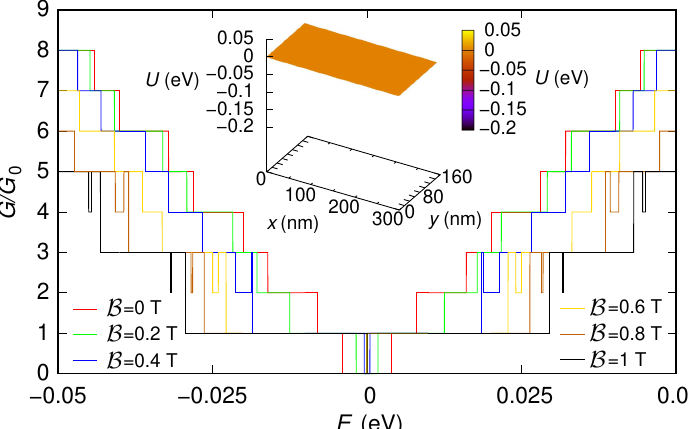
Figure 5. Conductance G , normalized with respect to the conductance quantum G 0 , which was obtained as a function of the Fermi energy E for six values of the orthogonal magnetic field B for the 150 nm-wide and 300 nm-long graphene ribbon with zero potential and without including the contacts. These results have been obtained using the “first gauge”. In the inset, we represent the potential profile that we have